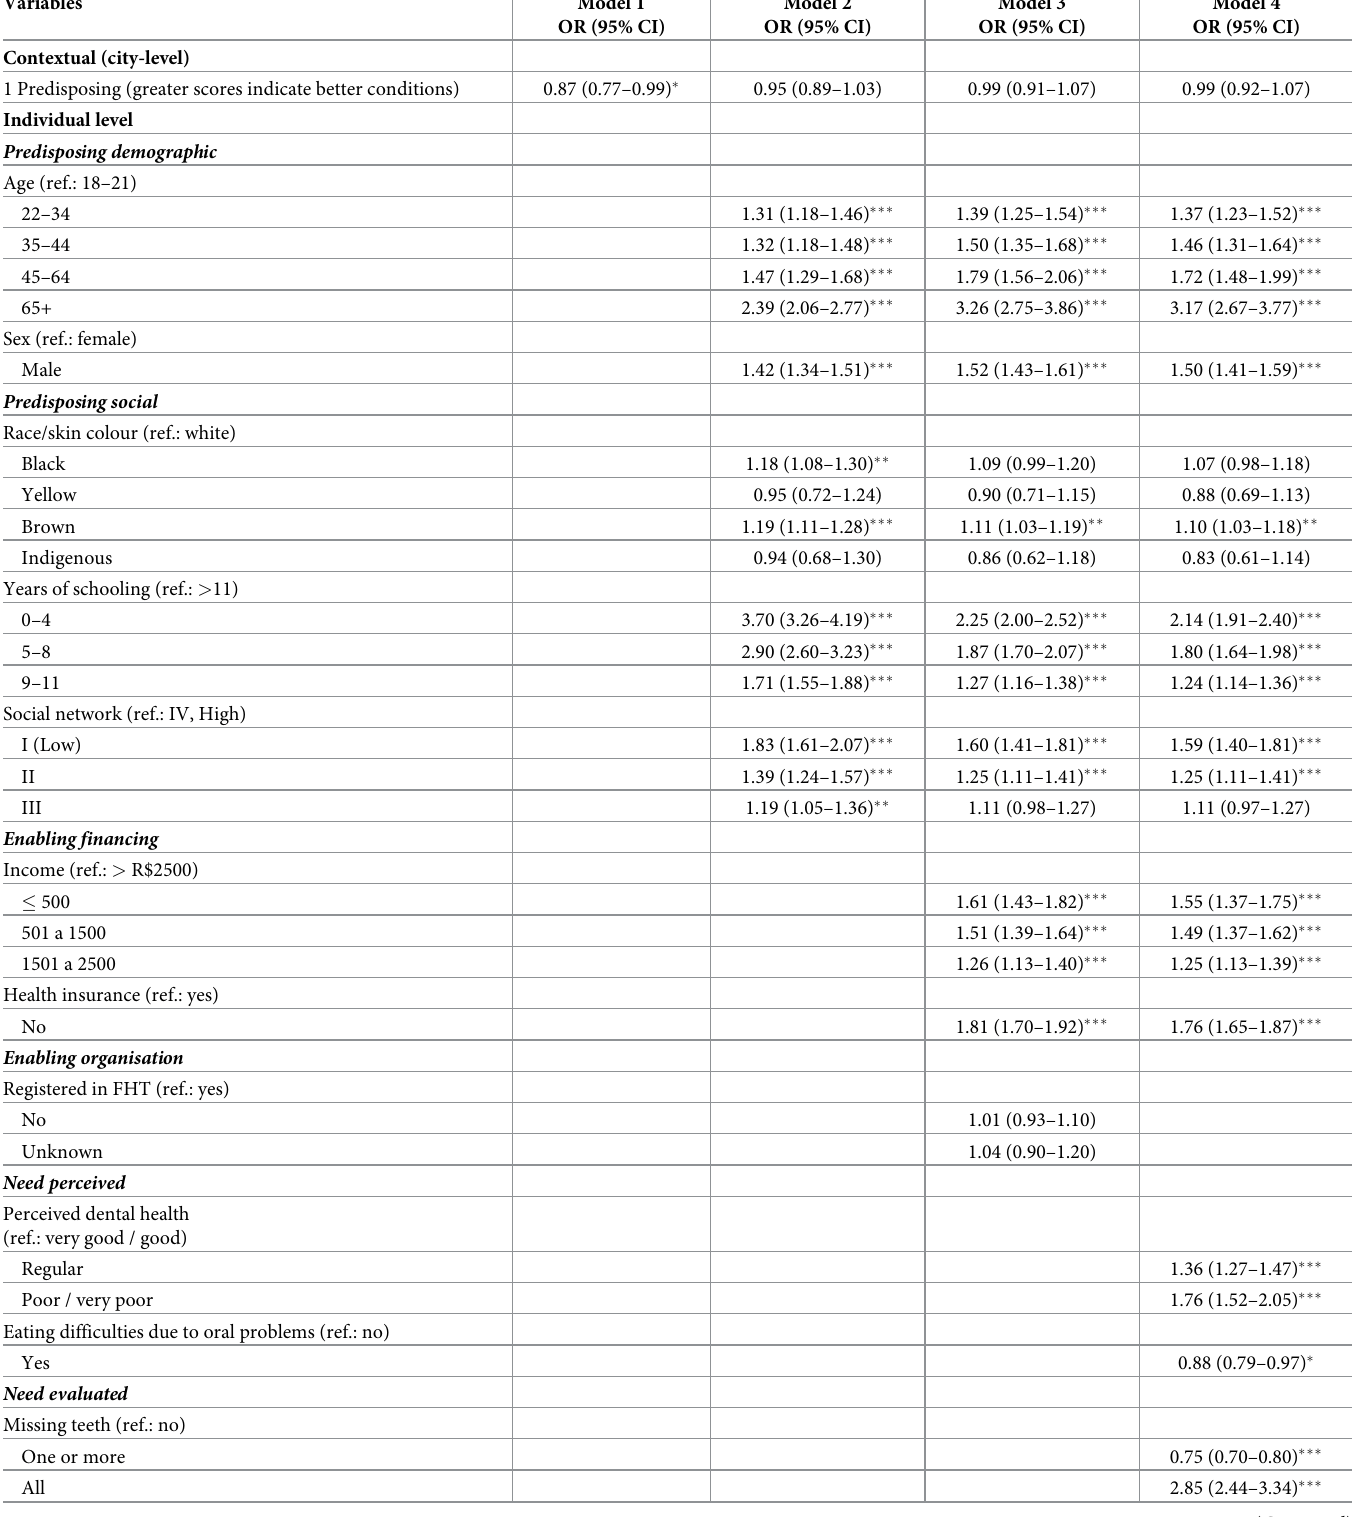
Table 5. Hierarchical multilevel analysis for last dental visit over 12 months ago, Brazil, State capitals, 2013 (n = 26,480).